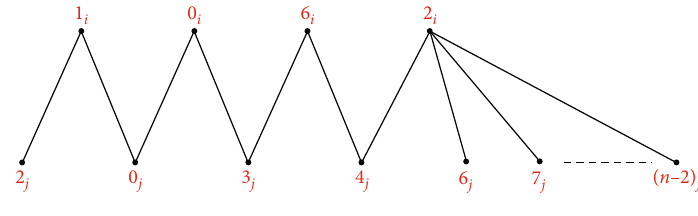
Figure 21: The labelling for ð C